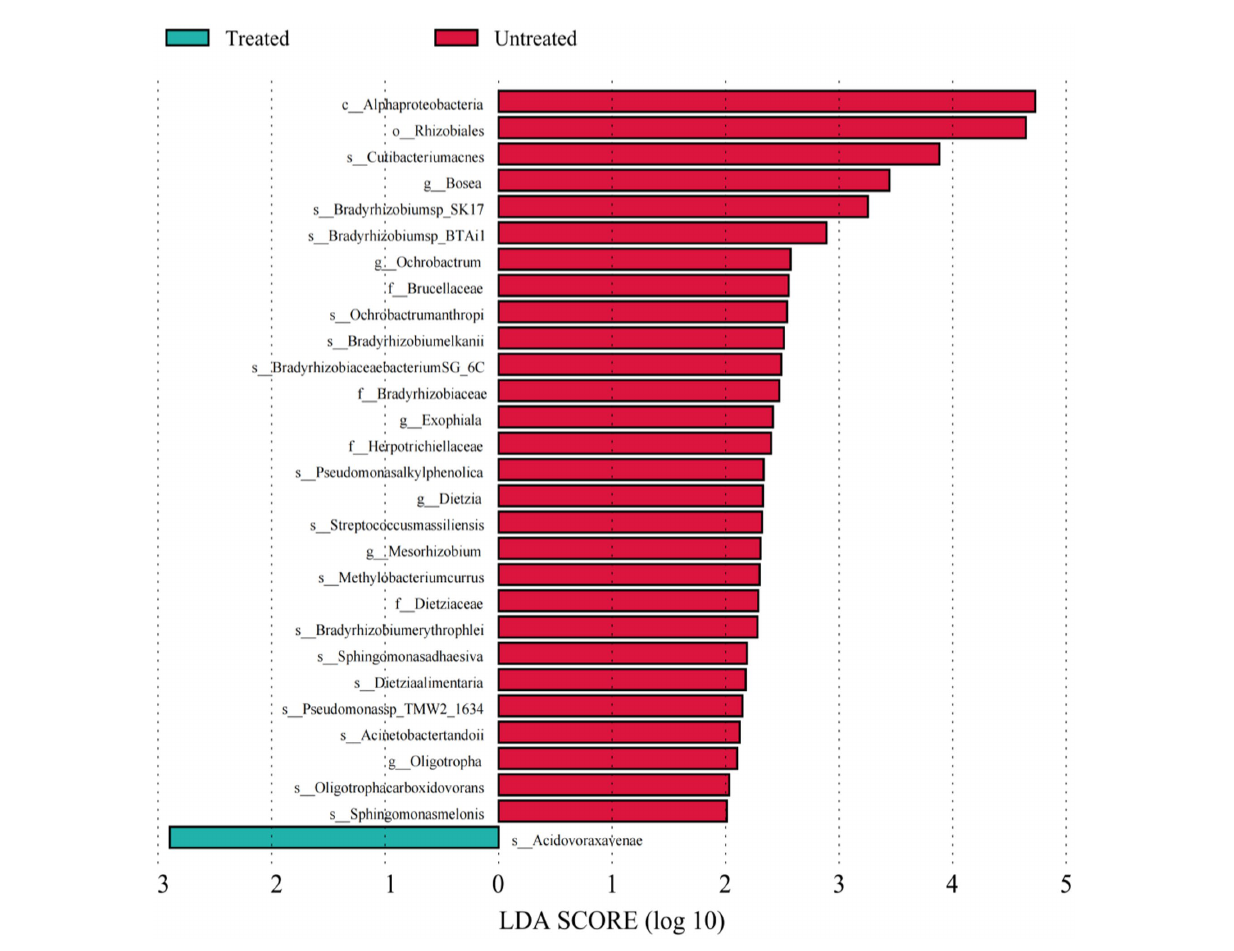
FIGURE 4 Linear discriminant analyses of bacterial species. Each column represents a bacterium, and the length of the column corresponds to the LDA value. The larger the LDA value, the larger the difference. The color of the bar corresponds to the grouping of characteristic